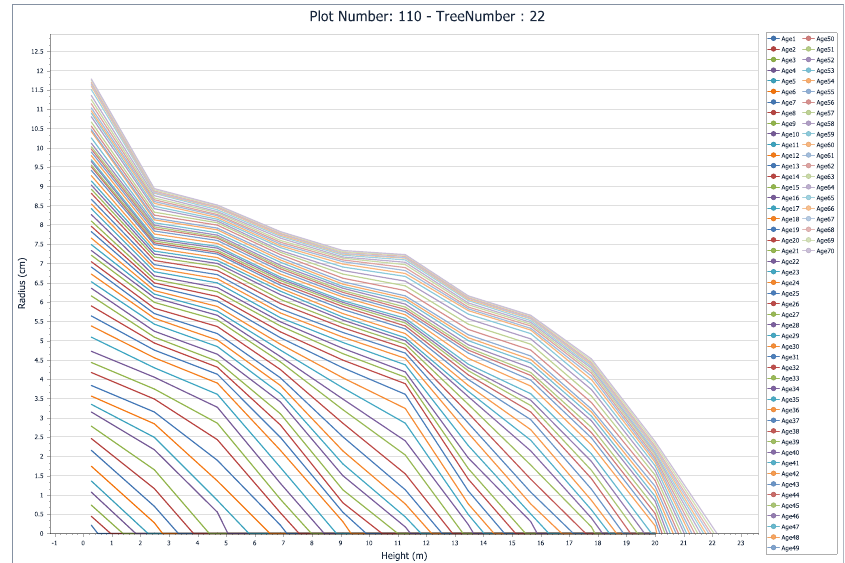
Figure 5. Entire growth layer profile for a 70 year-old jack pine tree.